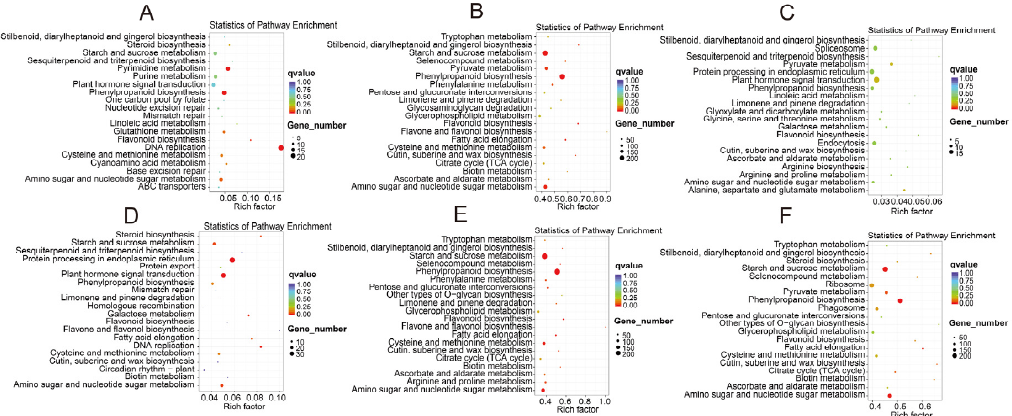
Figure 7. KEGG pathway analysis of differentially expressed genes in B. pervariabilis × D. grandis in four periods S1–S4. Note: ( A ): S2 vs. S1; ( B ): S4 vs. S1; ( C ): S3 vs. S1; ( D ): S3 vs. S2; ( E ): S3 vs. S4; ( F ): S4 vs. S2. Note: The color of the dot represents different qvalues, and the size of the dot represents the number of differentially expressed genes in this pathway.